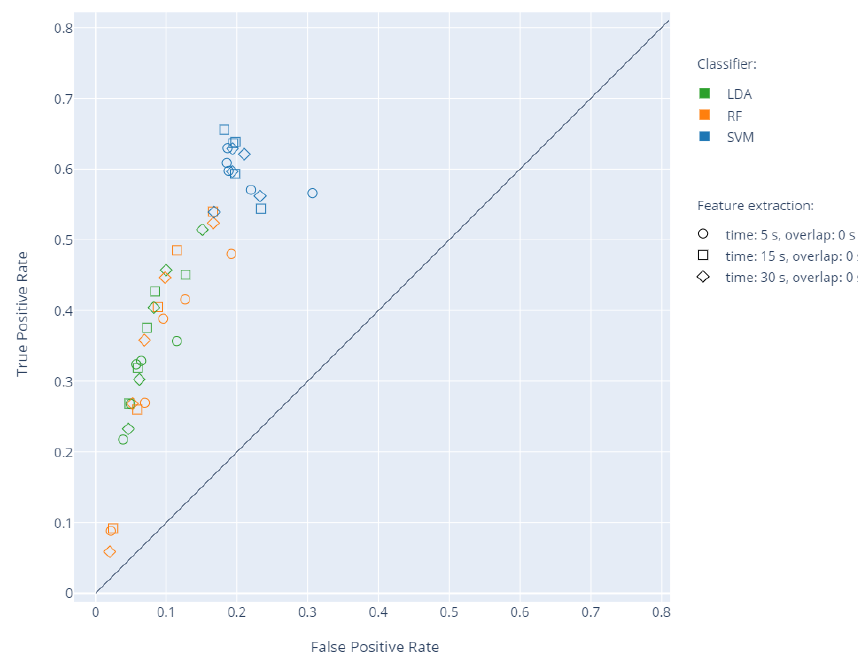
Figure 5. The individual results of cross-validation in the true positive rate (TPR) to false positive rate (FPR) space depending on the time window and the selection of a training set with different N values. The change in parameter N is represented by five identical markers for each pair of classifier and feature extraction window.